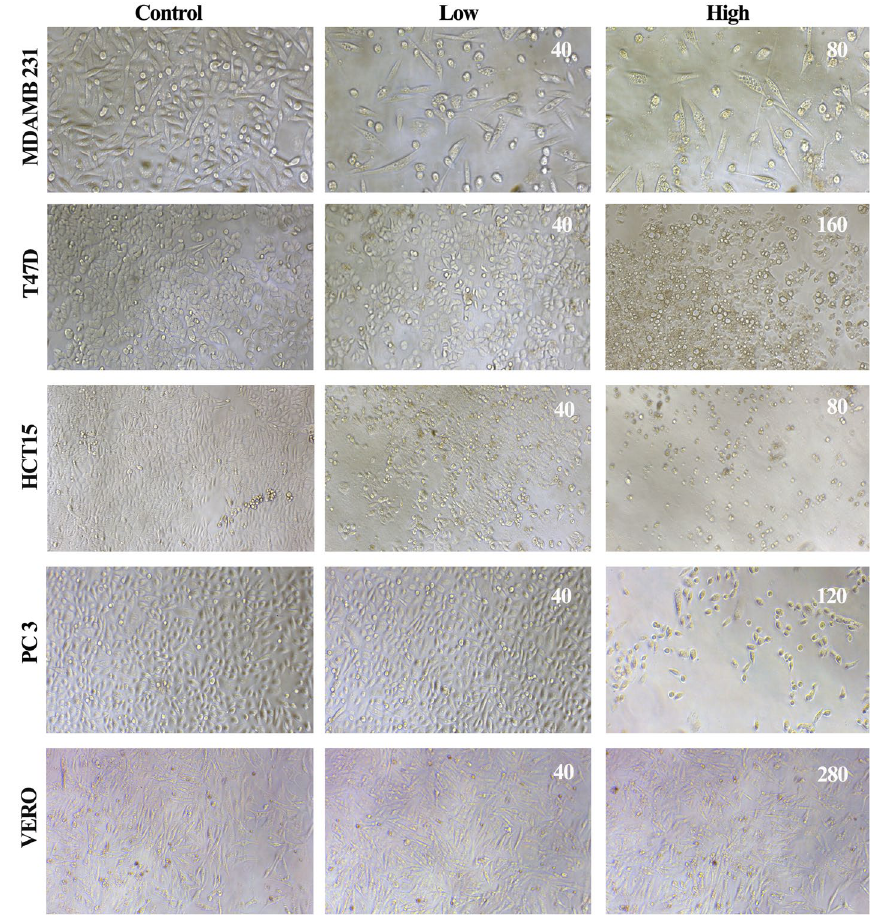
Fig. 3 Morphology of different cancer cell lines treated with K. pinnatum at different concentrations